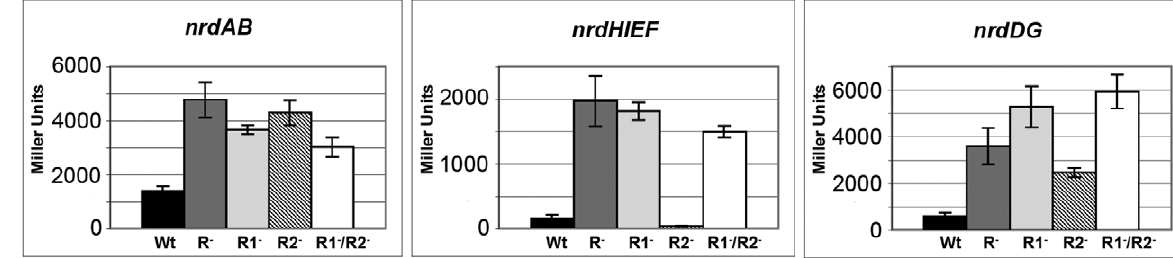
Figure 4. NrdR binding sites. A. S. Typhimurium LT2 nrdAB , nrdHIEF and nrdDG promoter regions. Black boxes indicate NrdR recognition sites and mutated sequences are showed below in bold lower case. 2 10 and 2 35 boxes are showed in bold. Transcriptional start site is indicated in bold and underlined as is the 19 bp Fur box in the nrdHIEF promoter region. The DnaA and FNR boxes are underlined for the nrdAB and nrdDG promoter regions, respectively. B. b -galactosidase activities of nrdAB , nrdHIEF , and nrdDG transcriptional fusions with mutagenized NrdR boxes are expressed in Miller Units (MU) for the wild-type strain (Wt), D nrdR strain (R 2 ), NrdR1 box mutant strain (R1 2 ), NrdR2 box mutant strain (R2 2 ), and NrdR1 and NrdR2 box double mutant strain (R1 2 /R2 2 ). Results are the mean values of duplicates of at least three independent experiments. Error bars represent the standard deviation of experiments.